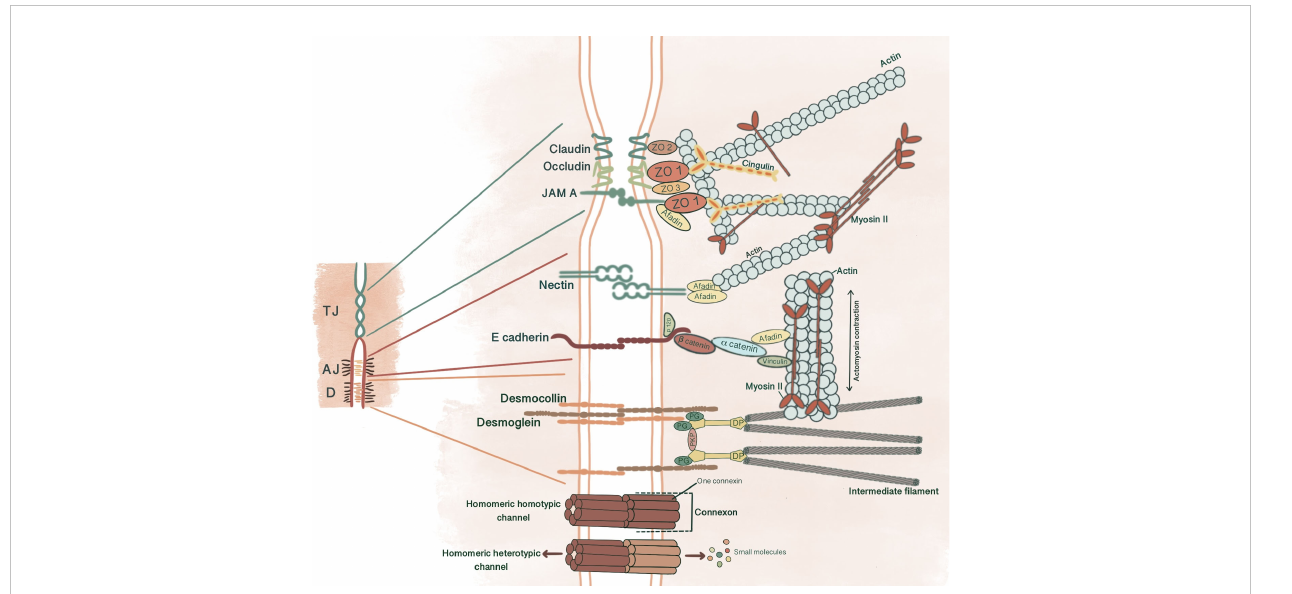
FIGURE 1 Simpli fi ed schematic presentation of basic structural components and molecular composition of intercellular junctions. (TJ, Tight junctions; AJ, Adherens junctions; D, Desmosomes; ZO, Zonula occludens; PG, Plakoglobin, PKP, Plakophilin; DP,